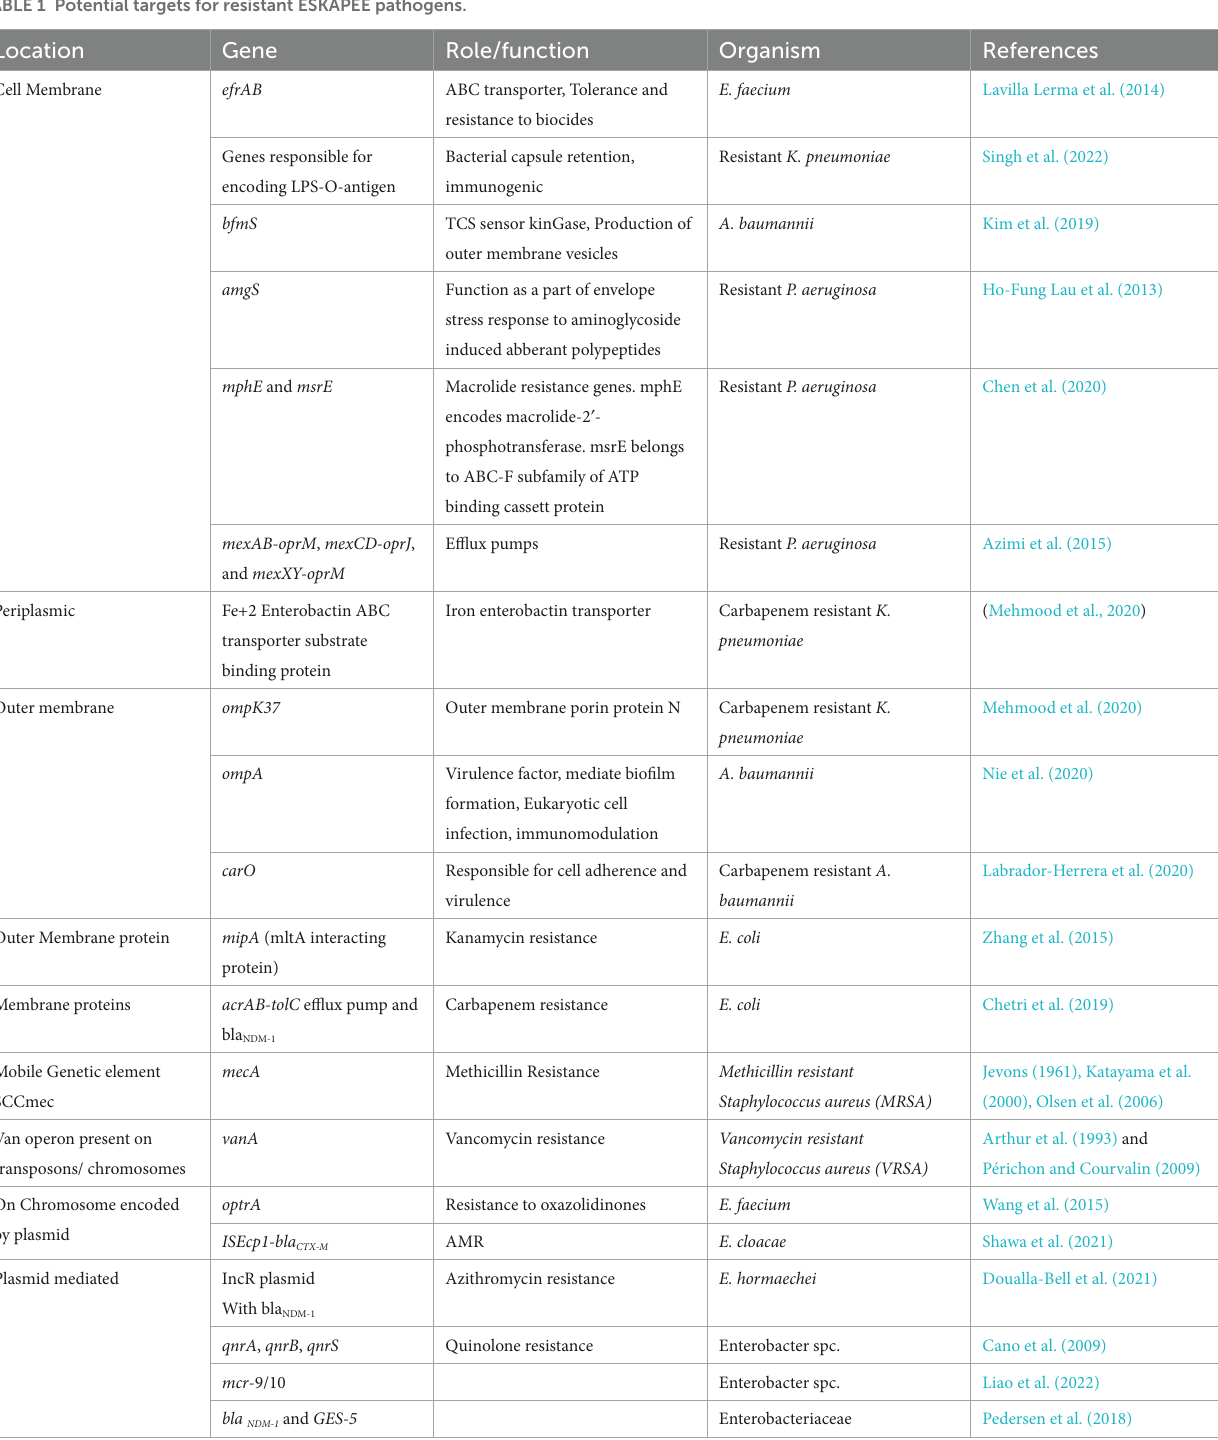
TABLE 1 Potential targets for resistant ESKAPEE